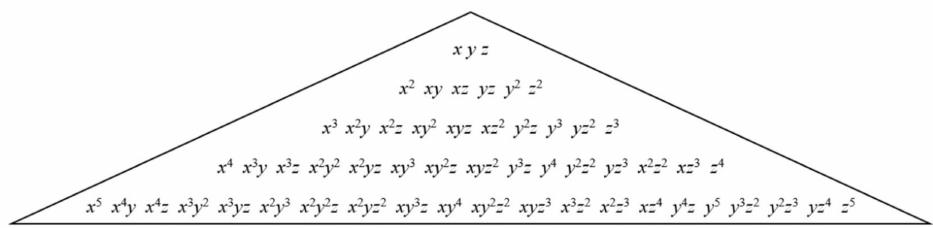
Figure 3. Pascal triangle for function with three